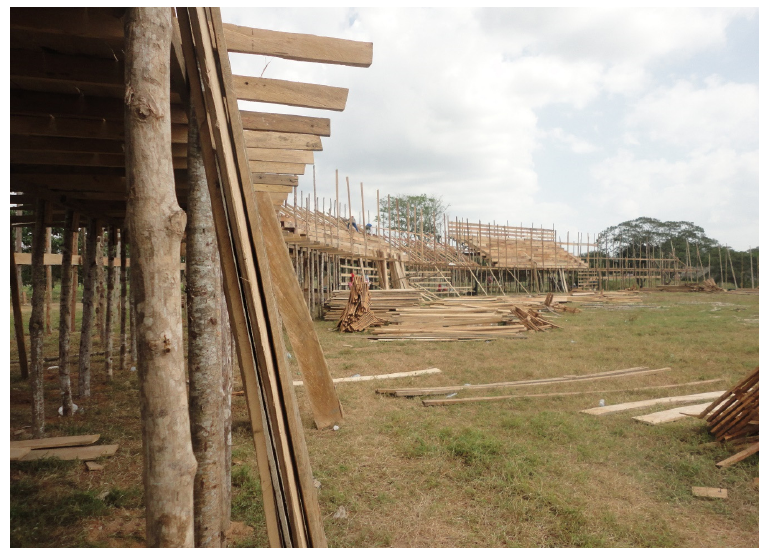
Figure 11. Image of the assembling of a Corraleja , where the main constructive elements are evident. Source: Merwan Chaverra, 2017